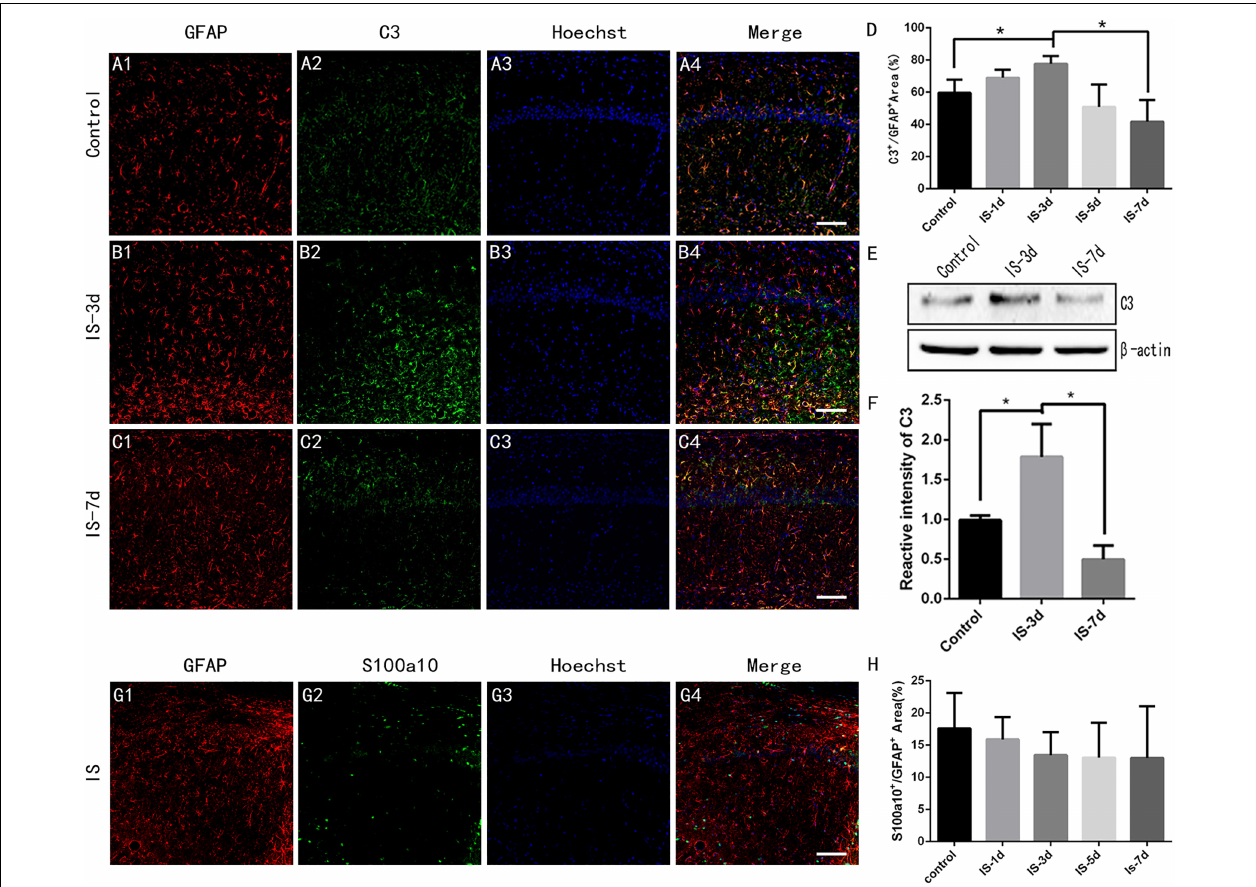
FIGURE 2 | A1 astrocytes were induced in rat hippocampus after 3 days of infrasound exposure. (A1–A4) A1 astrocytes in the CA1 region of the rat hippocampus double-labeled by C3 and GFAP in the control group without infrasound exposure, (B1–B4) in the group exposed to infrasound (IS) for 3 days (IS-3d), and (C1–C4) in the group exposed to infrasound for 7 days (IS-7d). (D) Quantitative analysis of percentage of C3 + /GFAP + area in the CA1 region of rat hippocampus. (E) C3 expression in rat hippocampus in control group, IS-3d group, and IS-7d group, by western blotting. (F) Semi-quantitative analysis of C3 expression in rat hippocampus in control group, IS-3d group, and IS-7d group. (G1–G4) A2 astrocytes in the CA1 region of rat hippocampus double-labeled by S100a10 and GFAP. (H) Quantitative analysis of percentage of S100a10 + /GFAP + area in the CA1 region of rat hippocampus. Nuclei stained with Hoechst. Scale bar: 100 µ m. N = 6–8 for each experiment. One-way ANOVA. Values are all expressed as mean ± SD. ∗ P <